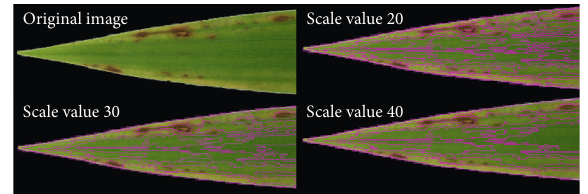
Figure 4: Segmentation under different scales for extraction of the necrotic spots.